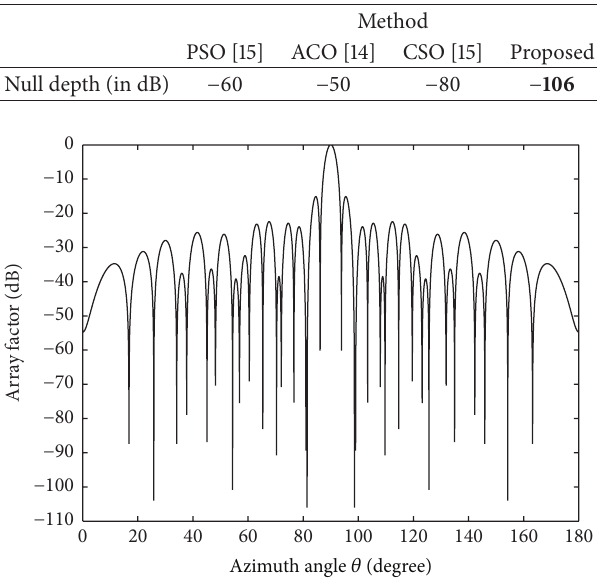
Figure 5: Array pattern for Example 3.